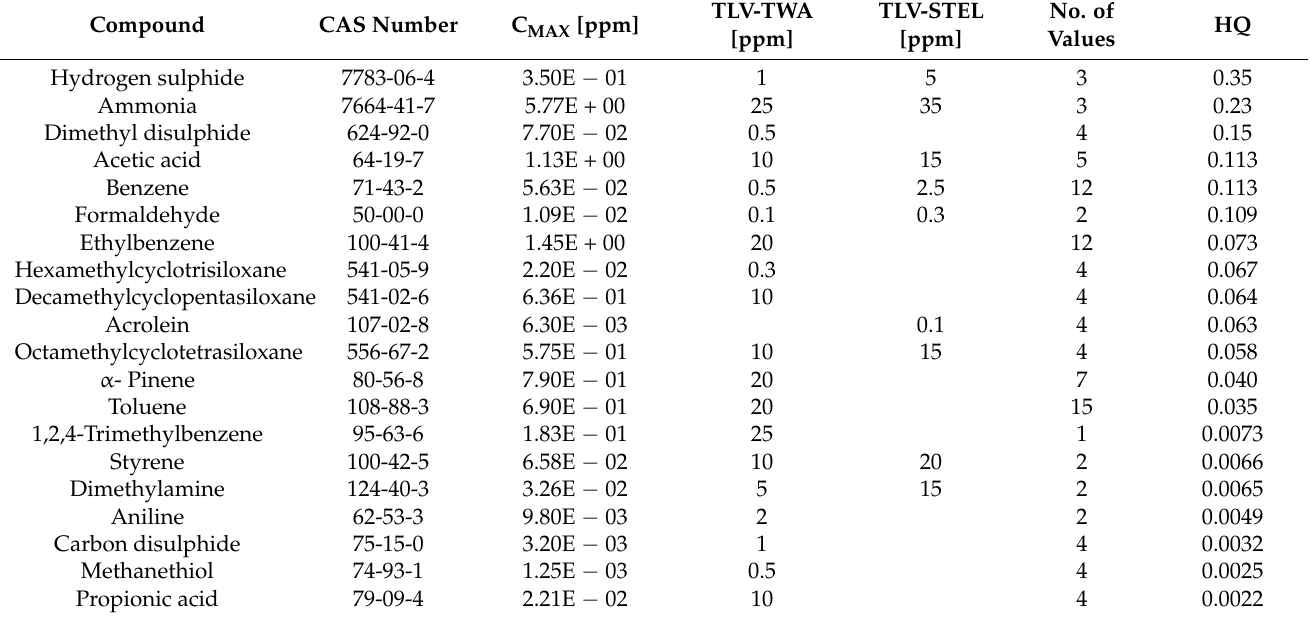
Table 2. Maximum concentration, number of values observed in the literature, TLV and HQ values relevant to the most critical compounds found in landfill leachate